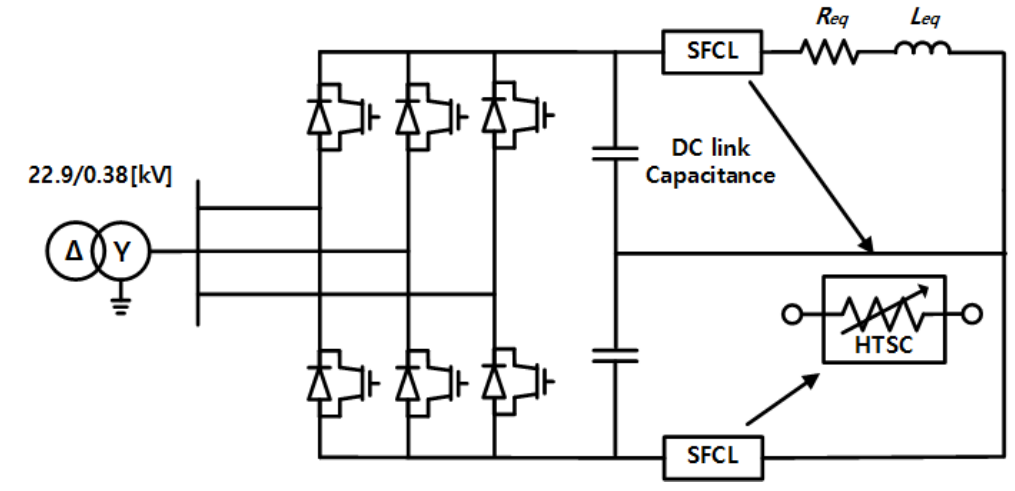
Figure 2. Concept of SFCL on LVDC system.